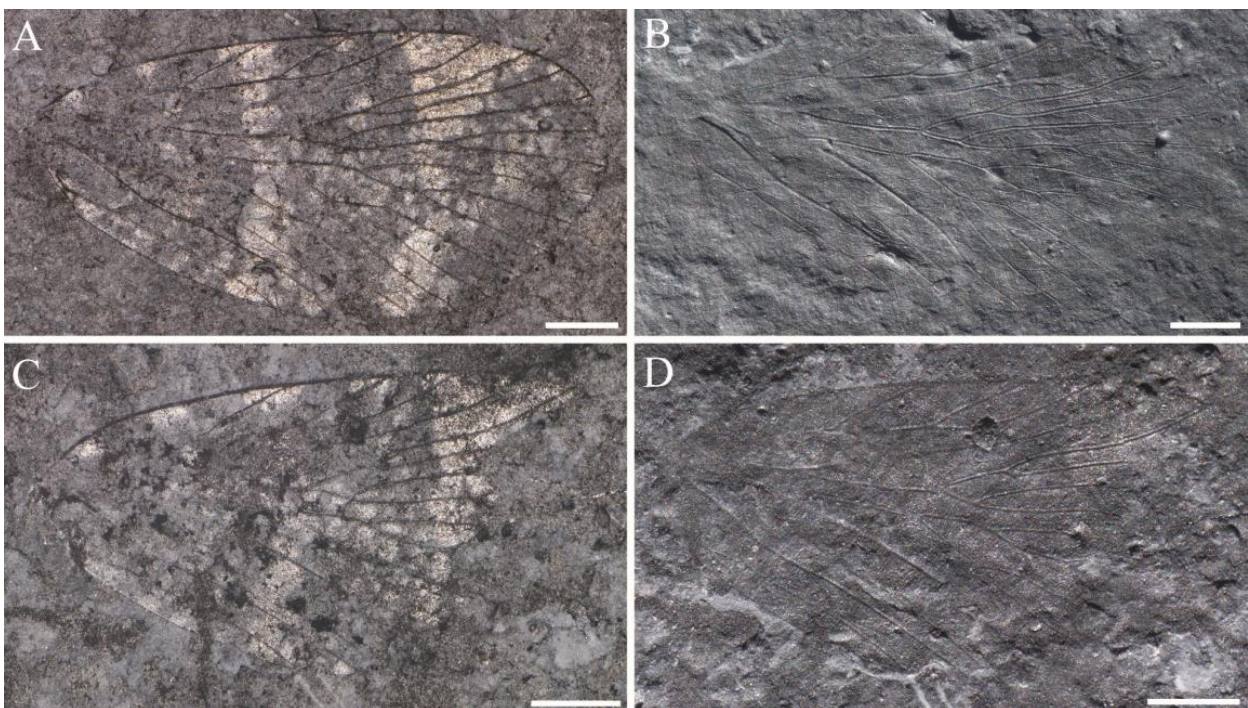
Figure 12. Sinoagetopanorpa grimaldii sp. nov. ( A , B ) Photographs of NIGP200922 (holotype); ( C , D ) Photographs of NIGP200923 (paratype); ( A , C ) were taken when specimens were immersed under 70% alcohol in vertical reflected light; ( B , D ) were taken in oblique reflected light. Scale bars represent 1 mm in ( A – D ).